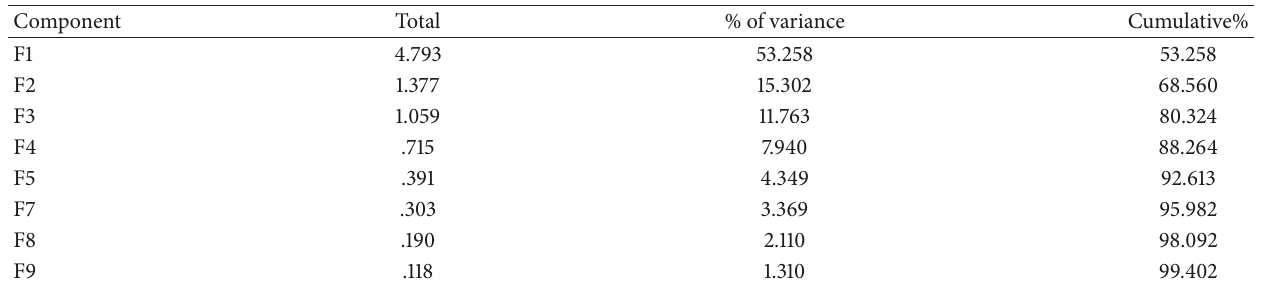
Table 4: Results of